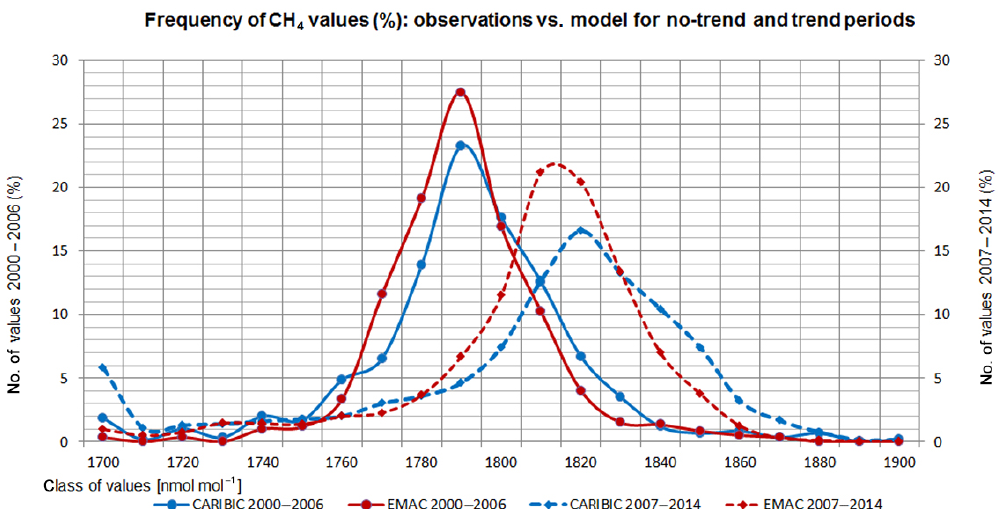
Figure 15. Frequency spectrum of CARIBIC-observed and EMAC-simulated CH 4 mixing ratios separately plotted for the years 2000–2006 and 2007–2014.